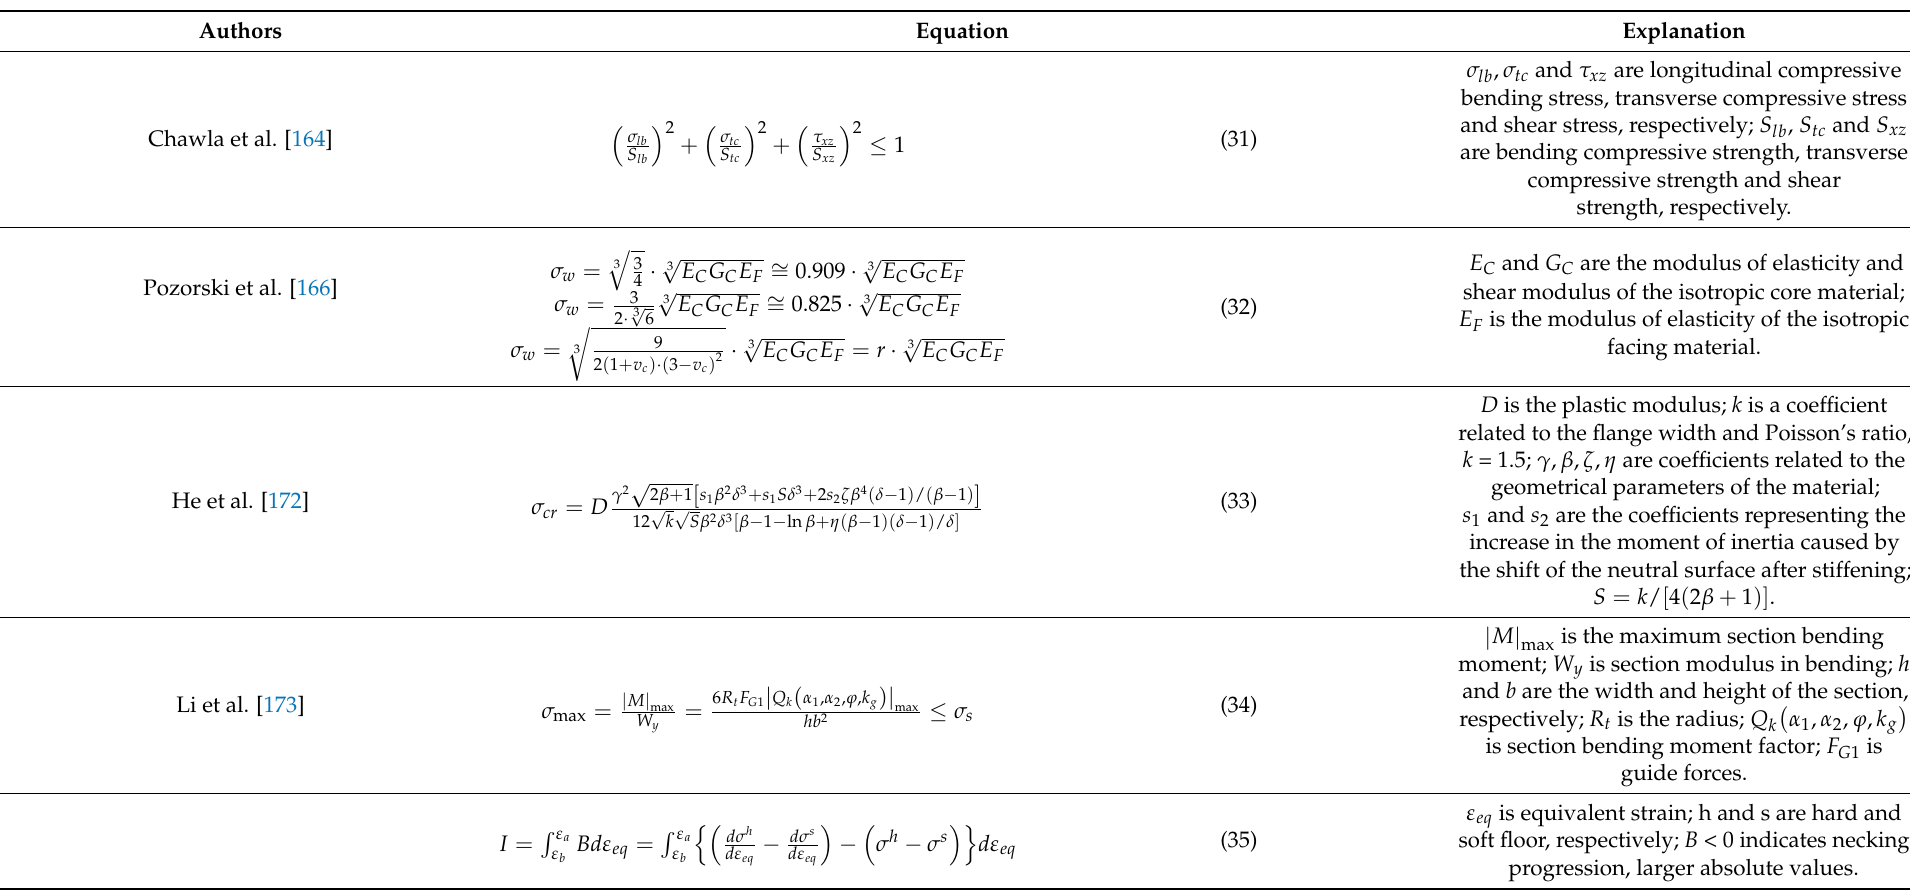
Table 5. Summary of instability criteria analytical equations.